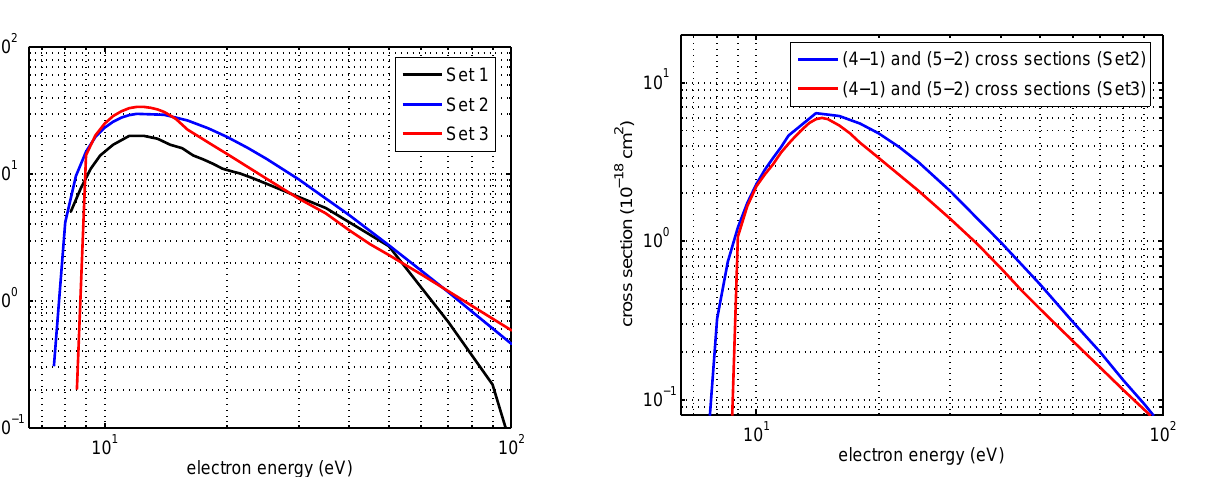
Fig. 5. Comparison between values of electron impact cross sec- tions of N 2 B 3 5 state for three cross section sets.